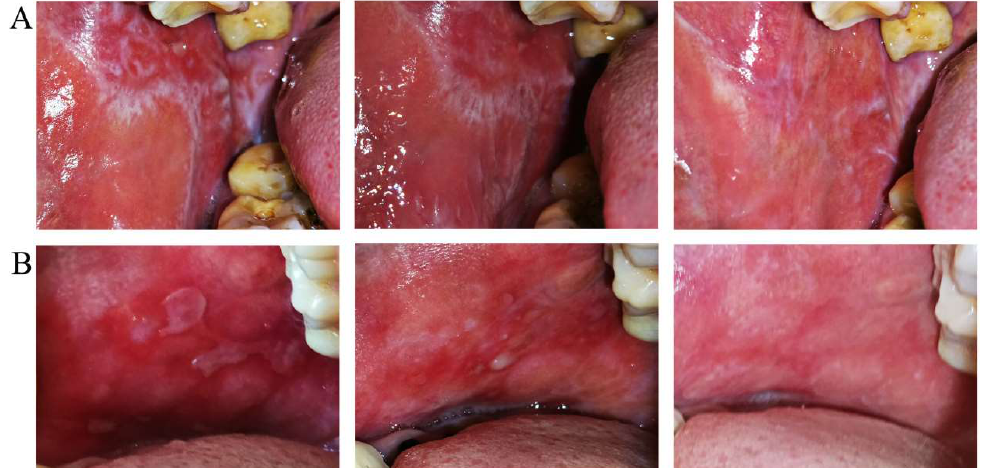
Figure 6. Magnitude of clinical responses of erosive OLP to dexamethasone plus gentamycin mouth- wash ( A ) and dexamethasone plus gentamycin mouthwash combined with TGP capsules ( B ). The left panel is the clinical presentation at the initial baseline, the middle panel is the clinical presentation at the 1-month follow-up, indicating improved erosion lesions, and the right panel is the clinical presentation at the 6-month follow-up, showing the erosion had disappeared or a few white lesions remaining (upper, Group A) and erosion had disappeared (upper, Group B). Table 6. Comparison of treatment effective rate between two groups with non-erosive and erosive OLP.